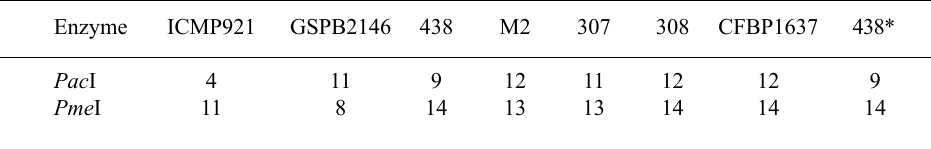
table 2. Restriction frequency for Pac I y Pme I enzymes in the eight genomes of Psm